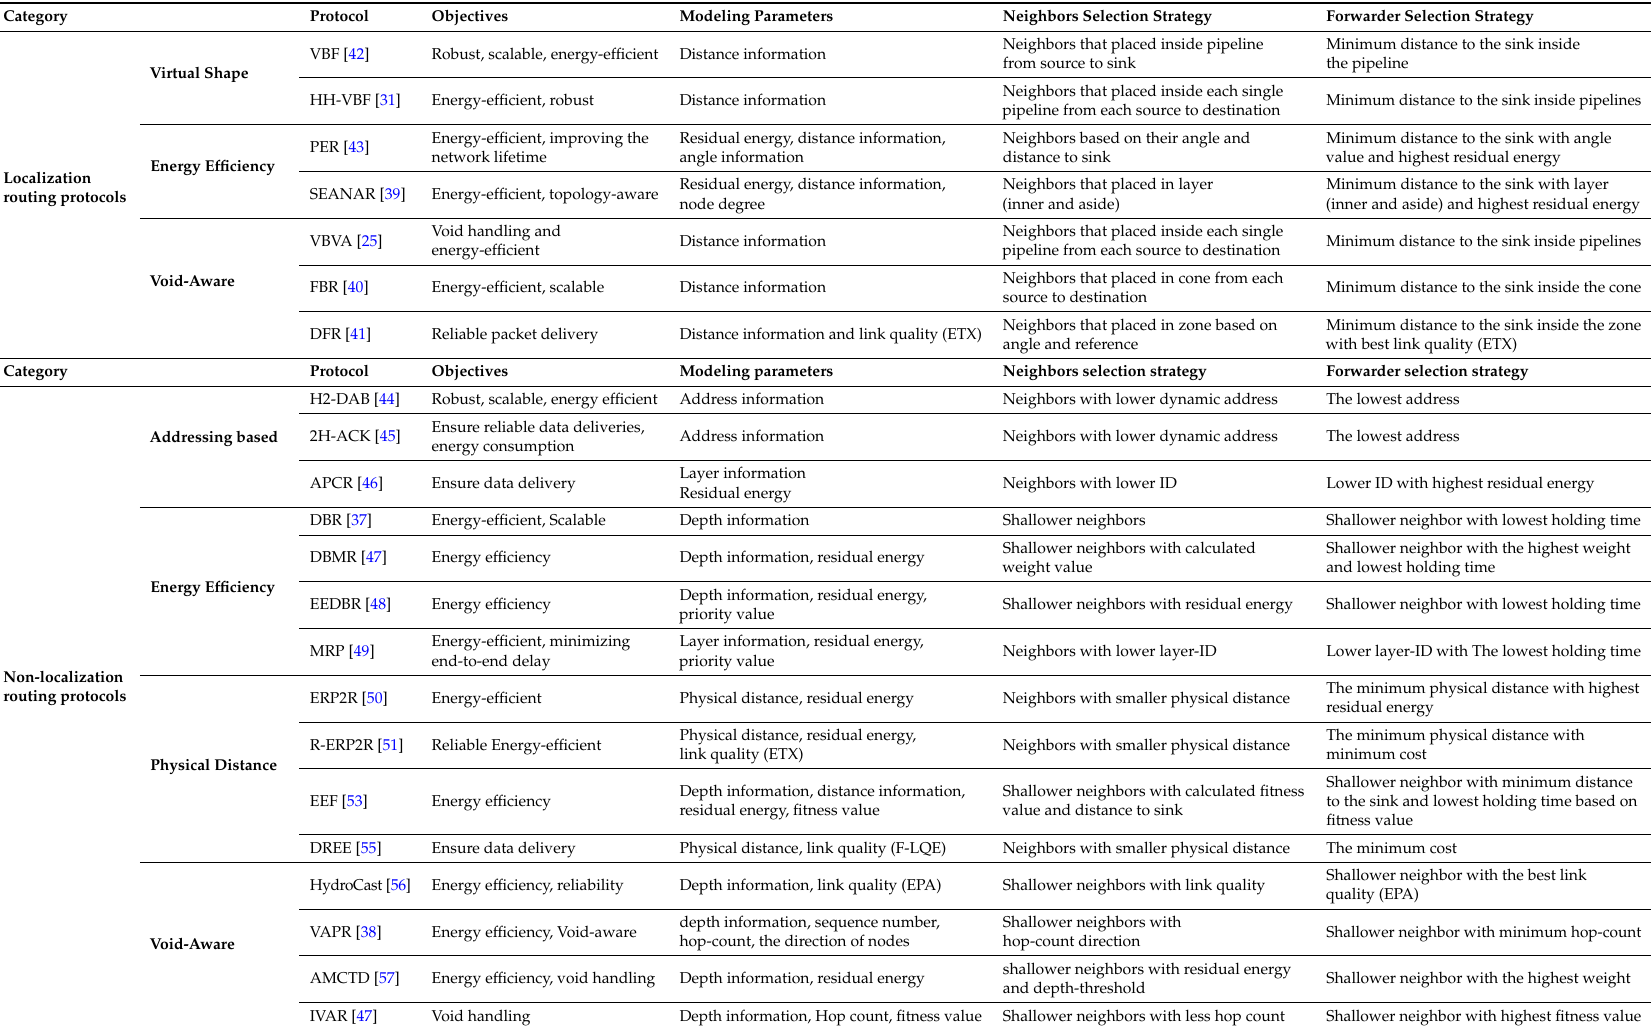
Table 1. Features of routing protocols in UWSNs in terms of selecting the next forwarding